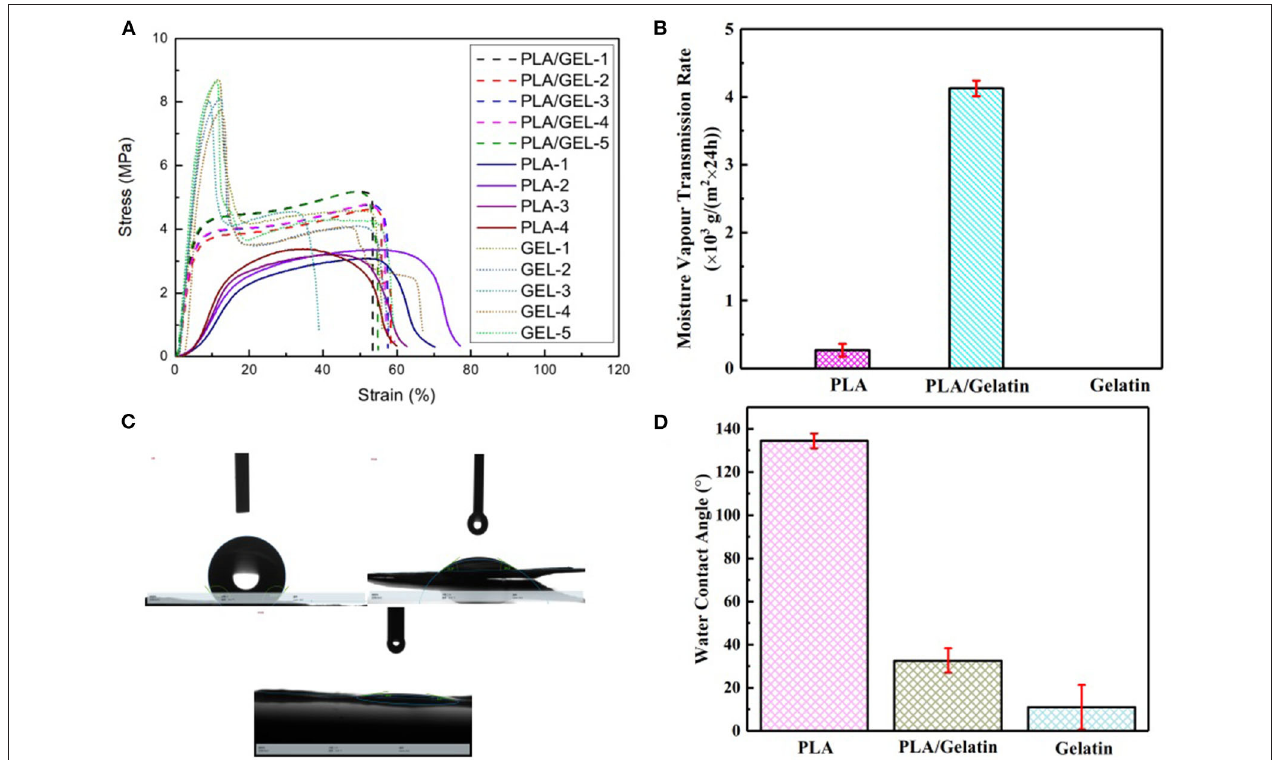
FIGURE 3 | Properties of electrospun PLA/gelatin materials. (A) Stress/strain relation curves of the gelatin (red), PLA (green), and PLA/gelatin (blue); (B) water vapor transmission rate; (C,D) water contact angle.